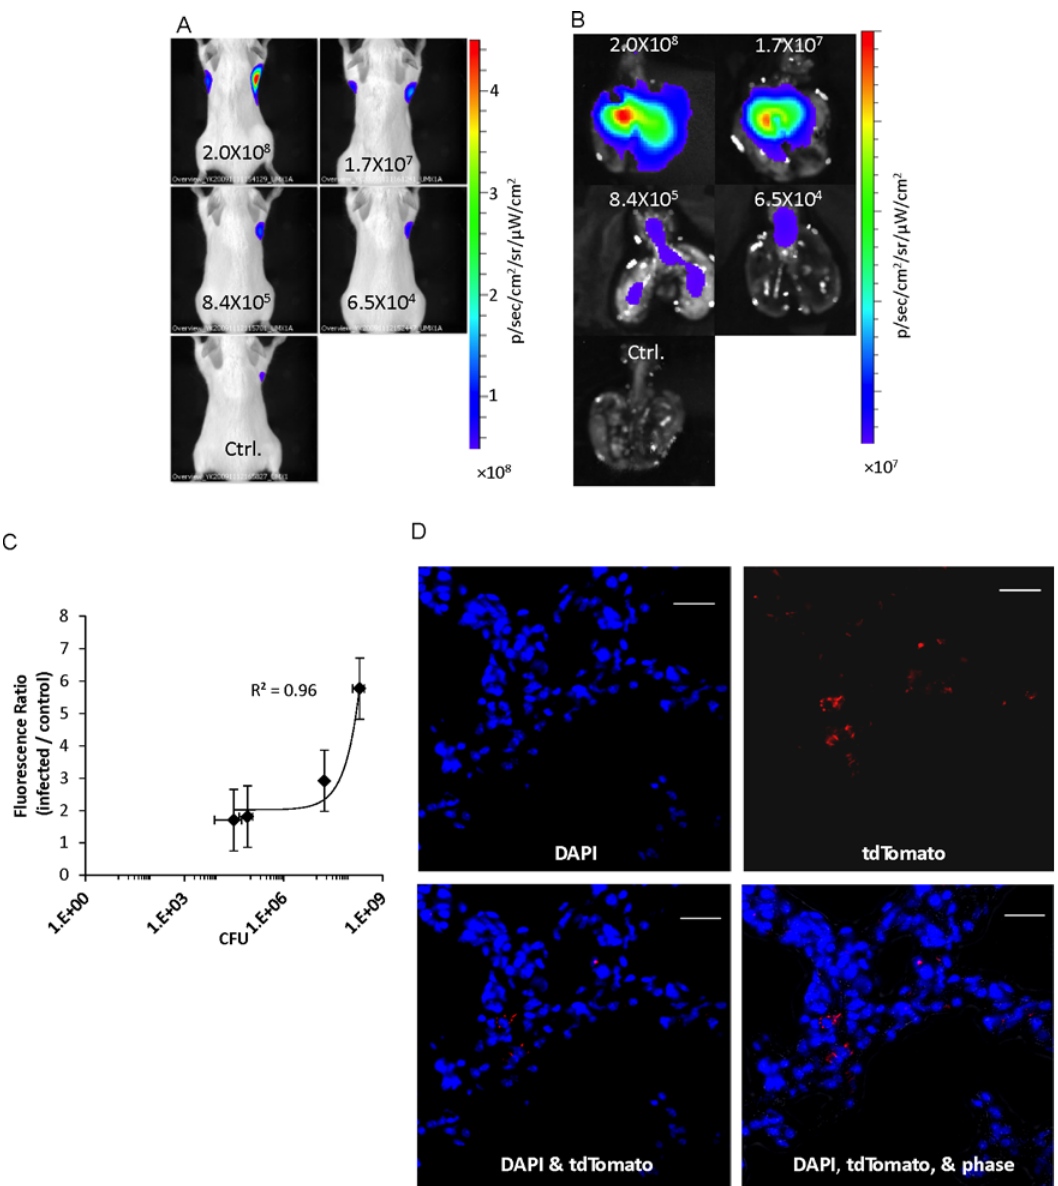
Fig 5. Imaging BALB/c mice infected intratrachealy with M . bovis BCG expressing L5-tdTomato. A. IVIS images of mice infected intratrachealy with the L5-tdTomato expressing strain. Images were acquired by trans-illumination at day 1 post infection. B. Images of the lungs harvested from the infected mice at day 1 post infection. Images were acquired by epi-illumination. Colony forming units (CFU) from plating dilutions on agar plates are indicated in the images. C. Quantitative analysis of images of the infected mice and the correlation between fluorescence ratios and CFUs. Four mice were infected for each dose of bacteria from technical replicates of the same culture. Data represents one of two independent replicate experiments. Value in Y-axis represents mean of fluorescence for each dose of bacteria. The error bars are standard deviations. D. Fluorescent microscopy of lung cryosections from BCG-L5-tdTomato intratracheally infected mice. Upper left: DAPI; upper right: tdTomato; lower left: merge DAPI and tdTomato; and lower right: merge DAPI, tdTomato and phase). White bars represent 20 micrometers.